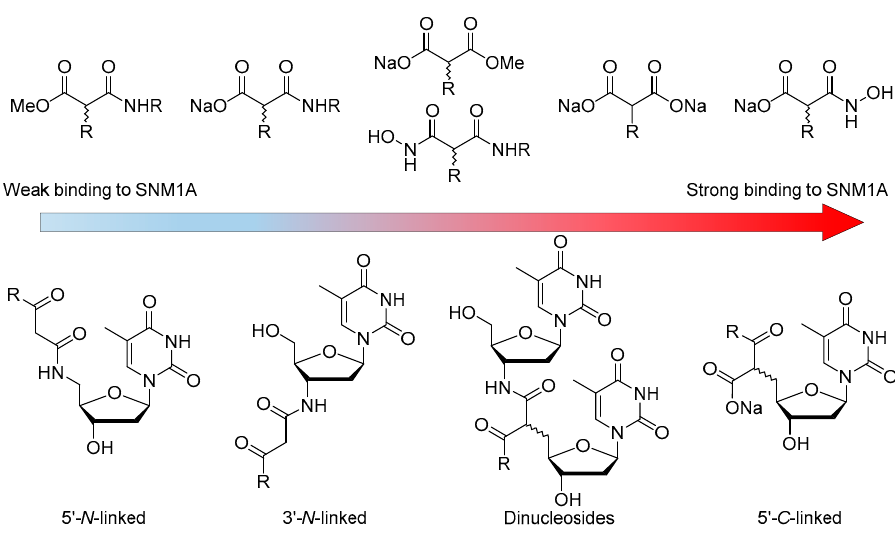
Figure 4. Trends observed from the analysis of modified (di)nucleosides in this work. Potency of the modifications increases in the following order: methyl ester malonamide < sodium carboxylate malonamide < hydroxamic acid malonamide ≈ monomethyl sodium malonate < disodium malonate < hydroxamic acid sodium malonate. For the site of modification, the observed trend is 5 ′ - N -linked < 3 ′ - N -linked < dinucleoside < 5 ′ - C -linked.